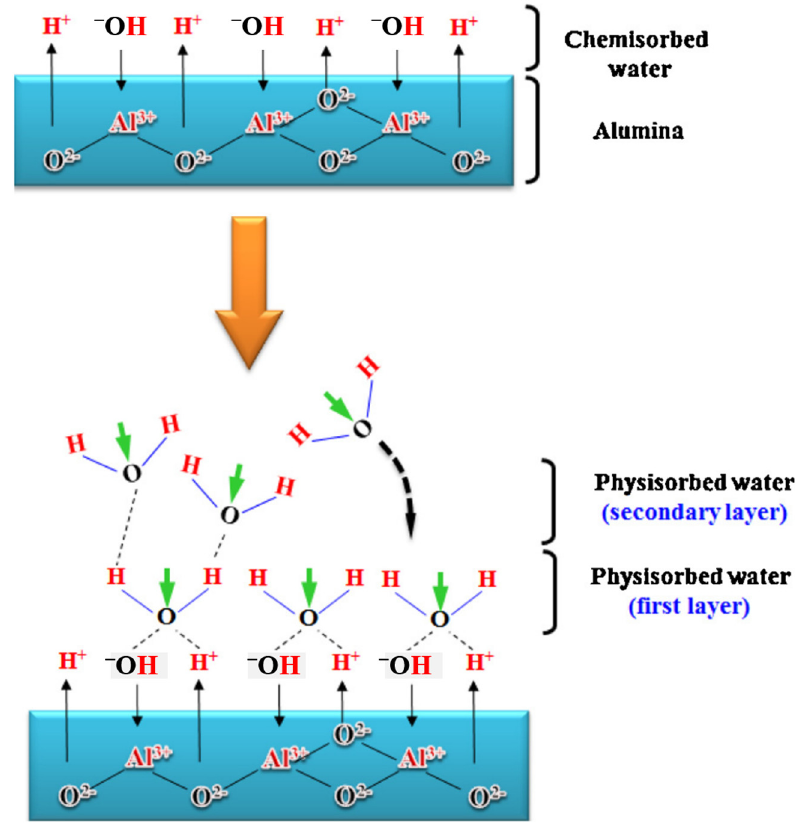
Figure 12. The water-vapor adsorption mechanism in ceramic humidity sensor [77].